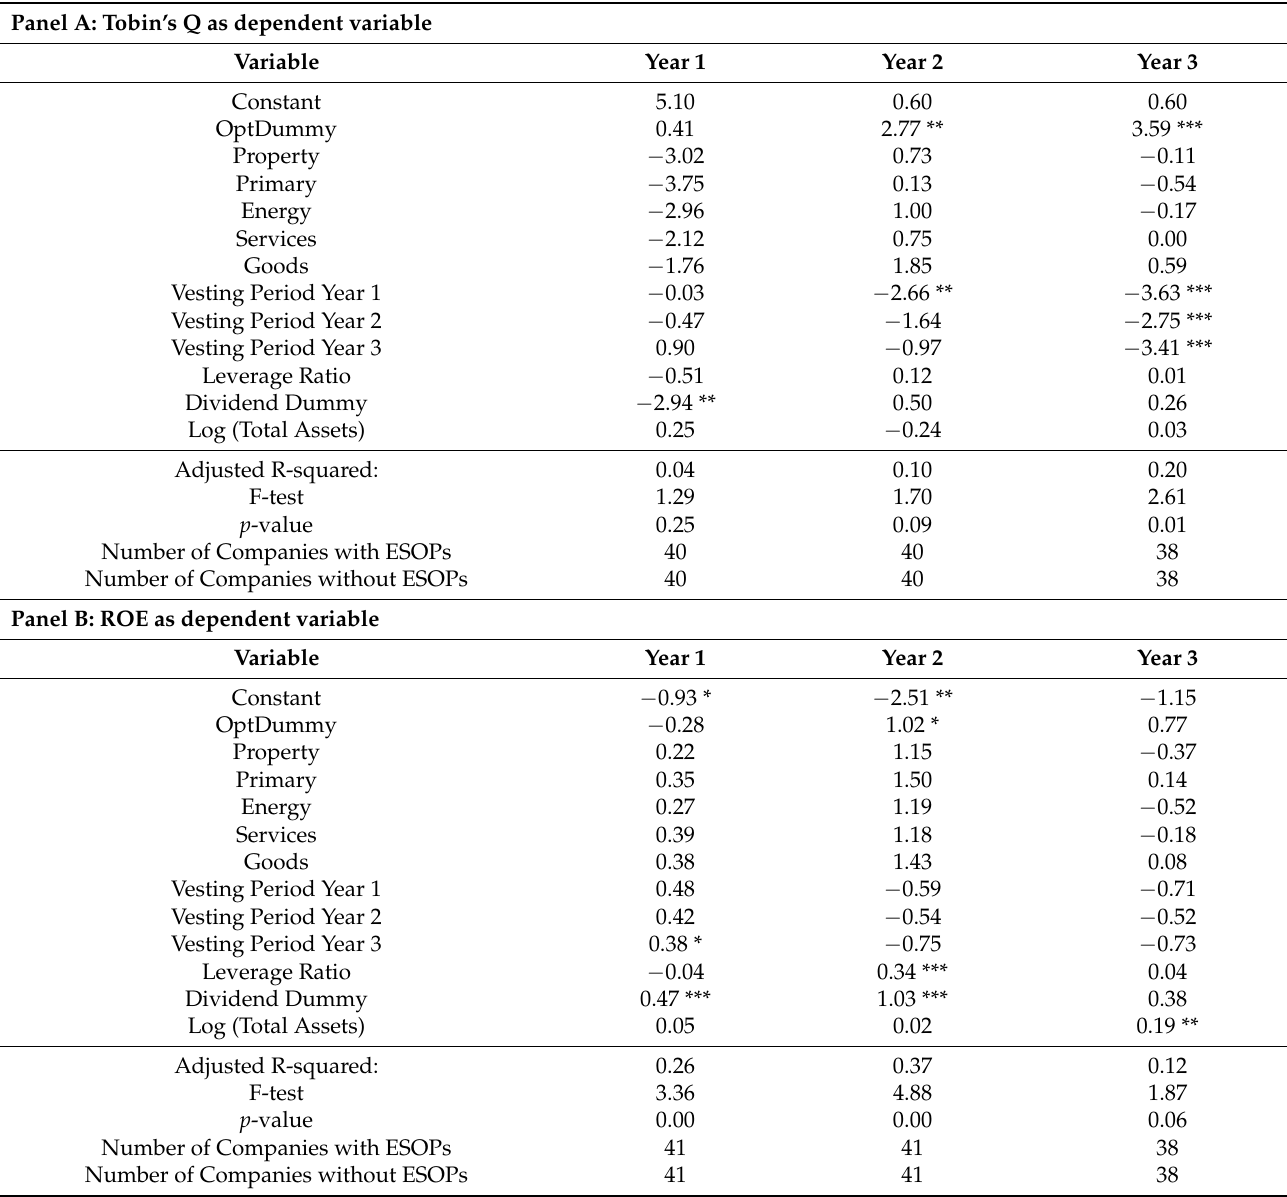
Table 6. ESOPs and firm performance with vesting period controls. Year 1 to Year 3 represent the years after the announce- ment. *, ** and *** are 90%, 95% and 99% levels of significance,